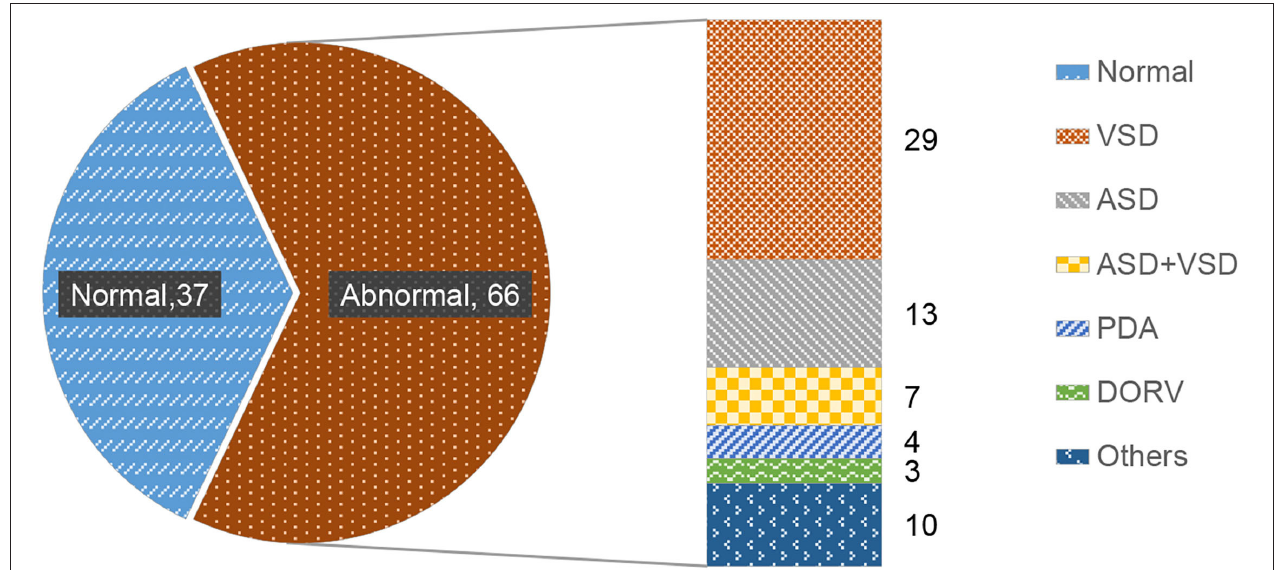
FIGURE 1 | Distribution of heart sound types. Normal heart sound (normal), ventricular septal defect (VSD), atrial septal defect (ASD), atrial septal defect + ventricular septal defect (ASD + VSD), patent ductus arteriosus (PDA), right ventricular double outlet (DORV), other pathological murmurs